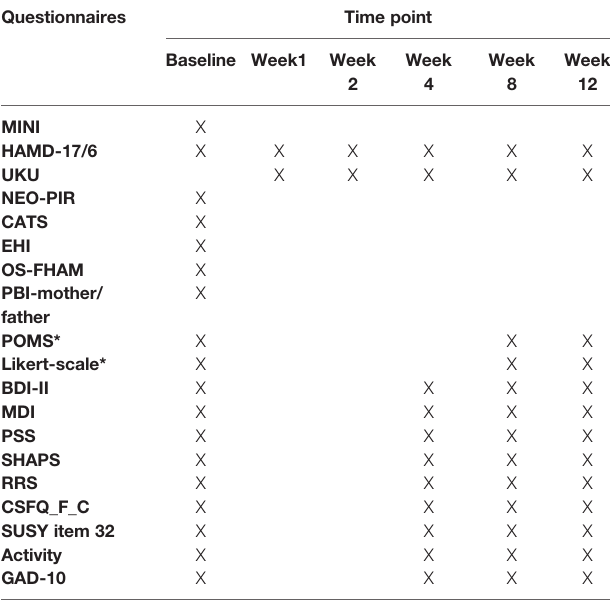
TABLE 1 | Table over questionnaires obtained throughout the study.